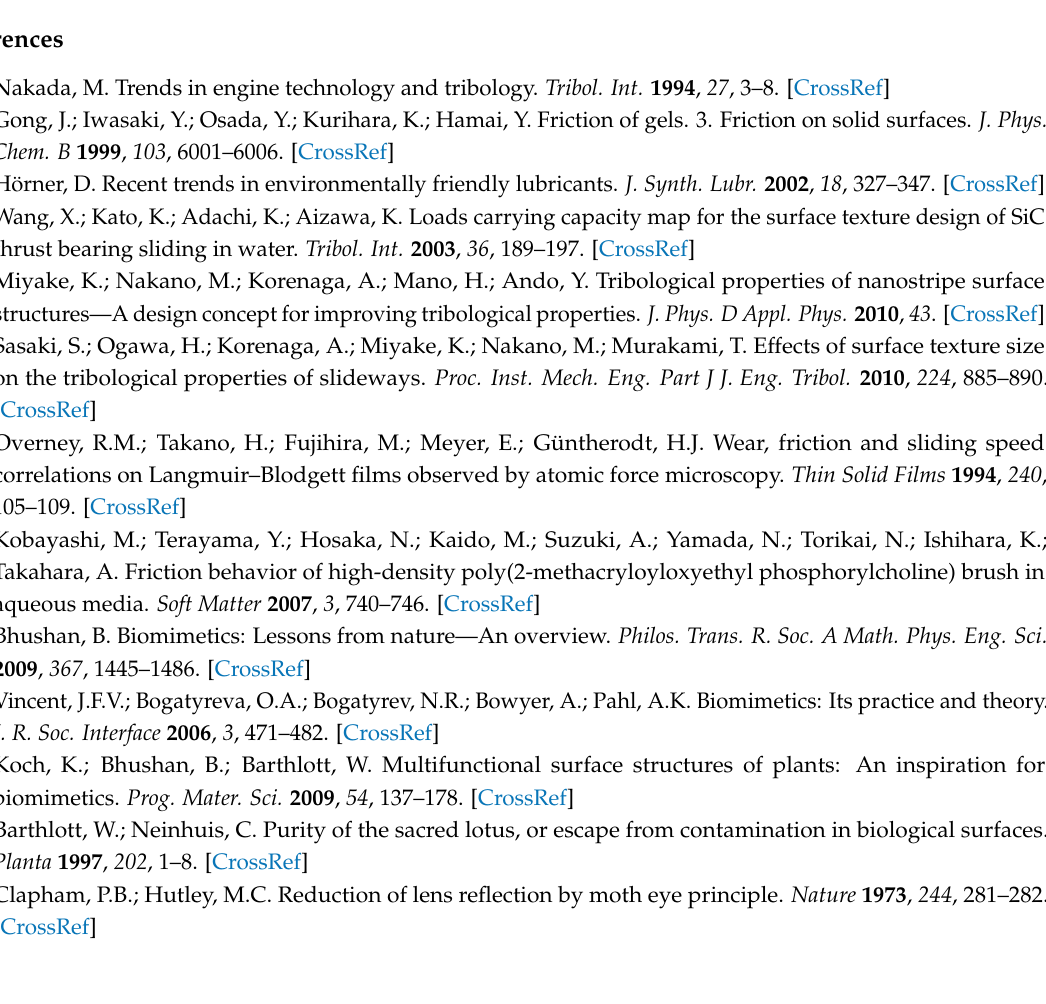
Figure S1: Photograph of a firebrat specimen used for AFM measurements (direct measurement of the friction forces of scales), Figure S2: Photographs of scales fixed on a silicon substrate for AFM measurements (detailed measurement of the friction forces of scales), Figure S3: Friction force images obtained by AFM, Table S1: Value data set for Figure 2A,B, Table S2: Information of the cantilevers used in Figures 4–6, Video S1: Contact of the firebrat prothorax region during movement of narrow space, Video S2: Frequent contact of firebrat head to surroundings during search for food, Video S3: Contact of the firebrat head to surroundings when a firebrat tries to cross a